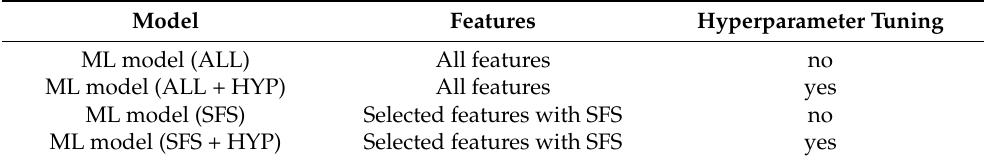
Table 3. Types of models used for training, validating, and